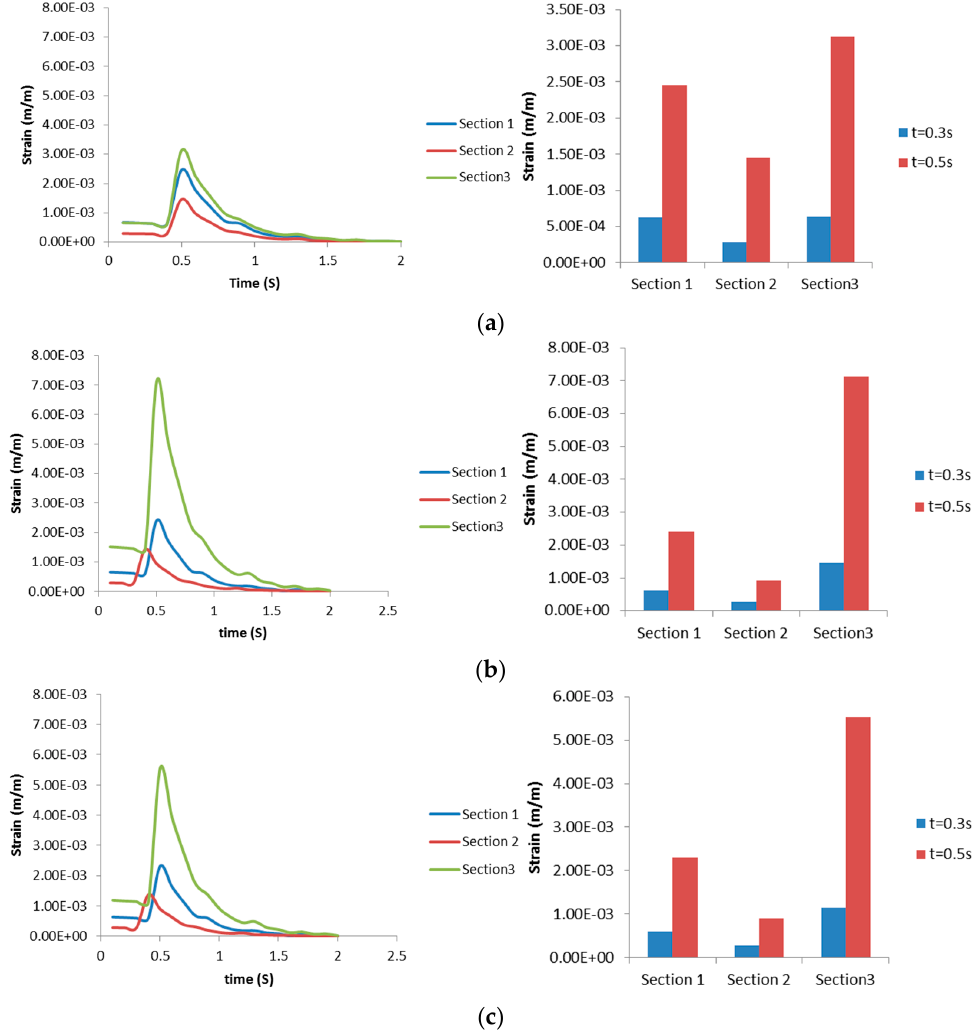
Figure 7. Maximum Von Mises strains in ( a ) Layer 1; ( b ) Layer 2; and ( c ) Layer 3. Right column shows strain progression over time, left column captures the Von Mises strain at a specific time for a clearer comparison.